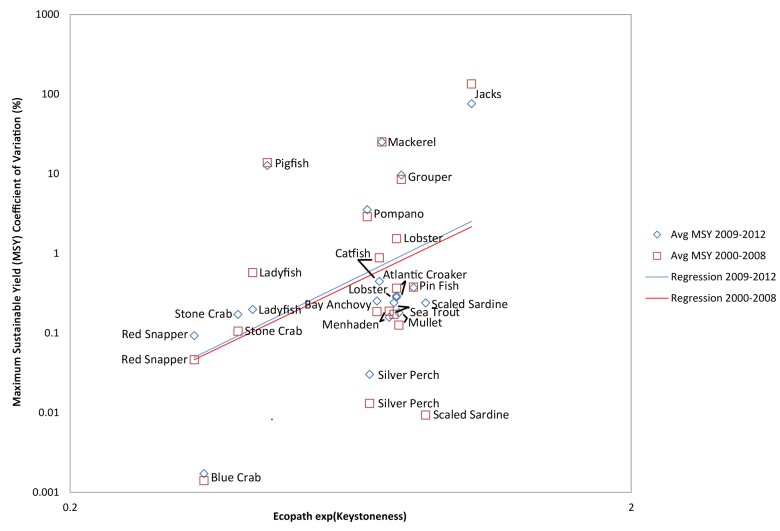
Accuracy of assessment model versus exponential Keystoneness by functional group.This figure illustrates the discrepancy (coefficient of variation) of Maximum Sustainable Yield (MSY) estimated between the (assessment) Pella-Tomlinson model and (operating) Ecospace model based on 2000 to 2008 data (red squares and regression line) and 2009 to 2012 data (blue diamonds and regression line). Keystoneness values were calculated by the Ecospace model. In general, ecologically important functional groups (towards the right of the figure) should be assessed by FIM programs with greater rigor and accuracy than other functional groups, providing a negative slope overall. That is not the case. Regression line slopes were significantly different from zero (t-test: 2000 to 2008 P-value = 0.05, 2009 to 2012 P-value = 0.01; values log-transformed), but not one another.